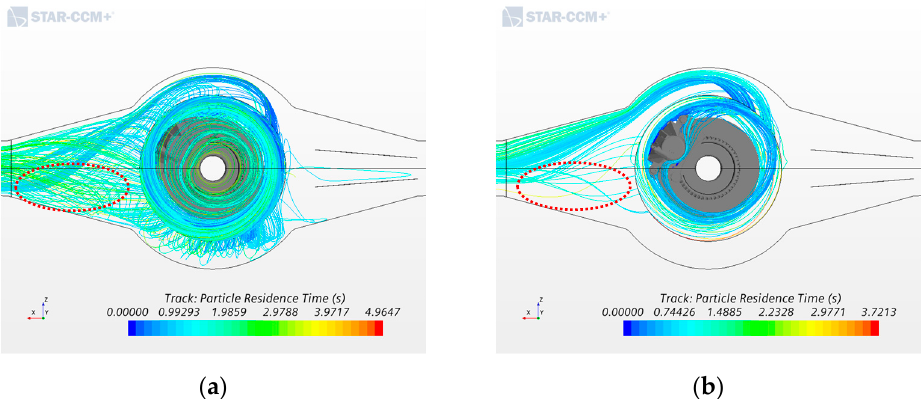
Figure 15. Particle residence time and trajectory of the particles for the inlet duct: ( a ) two splitters; ( b ) four splitters.